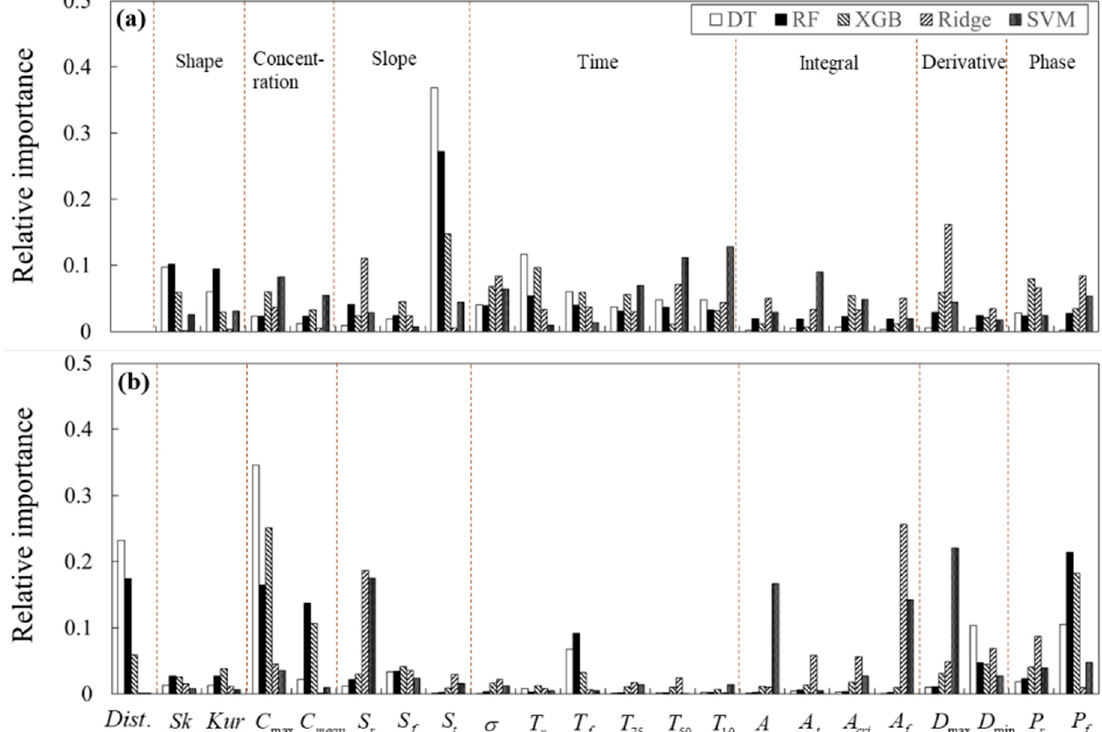
Figure 6. BTC feature importance by each ML model from Model 1 for ( a ) the prediction of the spill location and ( b ) the prediction of the spill mass.